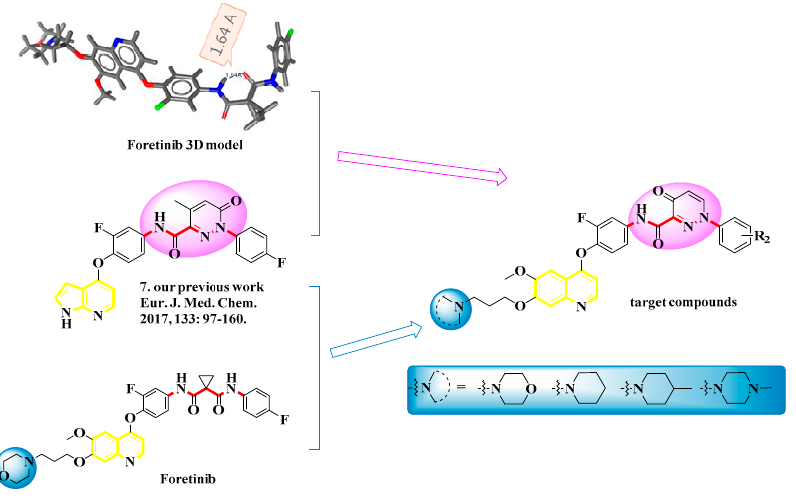
Figure 2. Structures and design strategy for target compounds.